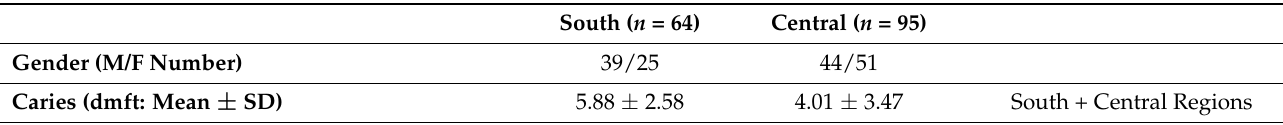
Table 1. The significant association between caries (dmft) and certain CCDI manifests vs. the SES categories for the present cohorts